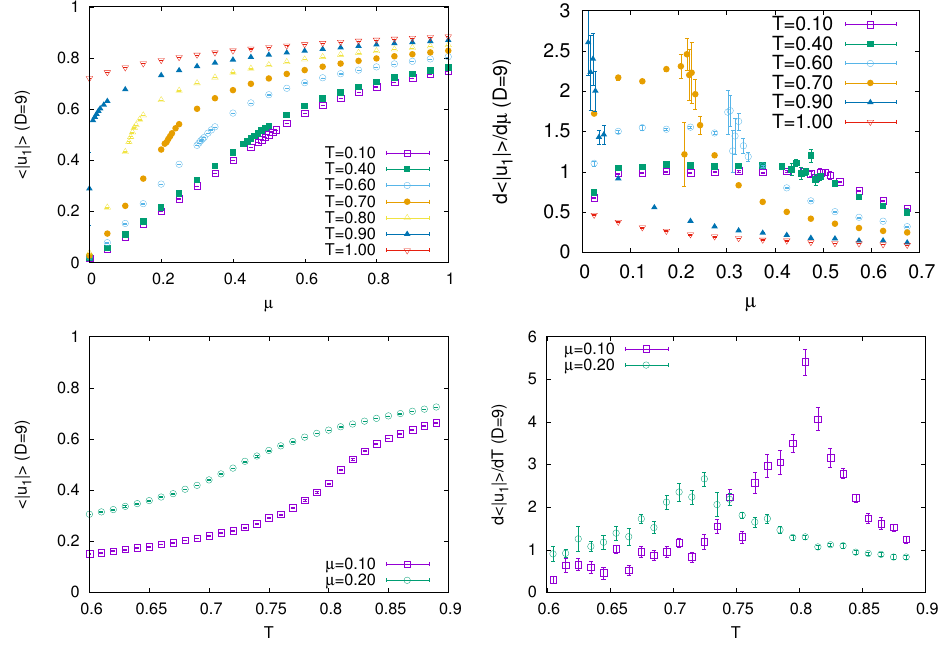
Figure 4 . hj u 1 ji (left) and d hj u 1 ji